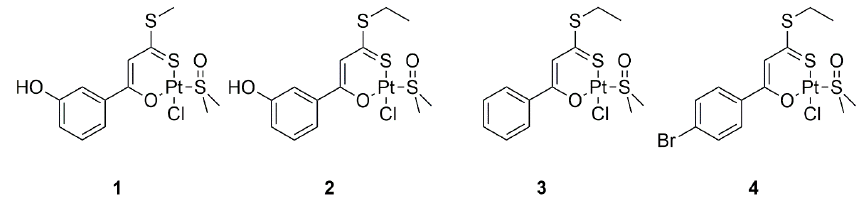
Figure 1. Chemical structures of Pt(II) complexes used in this work.